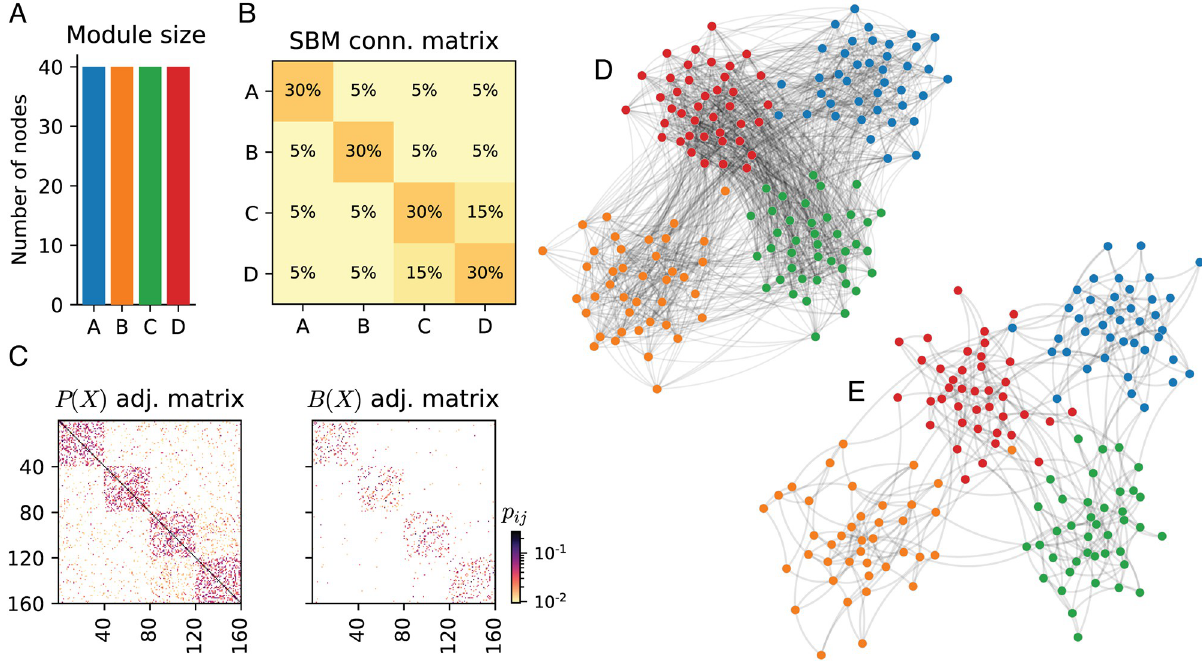
Fig 3. Synthetic network with connectivity generated by a Stochastic Block Model (SBM) and edge weights sampled from the SocioPatterns French Primary School (Fr-PS) contact network. ( A ). Synthetic module sizes. ( B ). SBM generator matrix for low connectivity case. Note the hierarchical structure of modules C and D. ( C ). The adjacency matrix of the original graph and the metric backbone. ( D ). Force layout visualization of the original (proximity) graph as computed by the NetworkX python package [52]. Node positioning obtained after 100 iterations. ( E ). Force layout visualization of the metric backbone subgraph. Node positioning seeded from the original graph (panel C ) and obtained after 100 iterations. See Sections A and 4 in S1 Text for details about synthetic network generation.